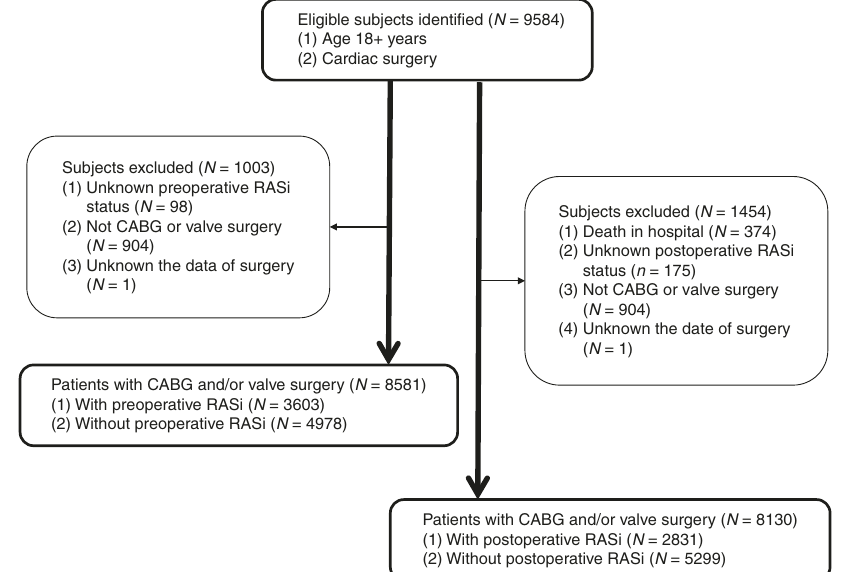
Fig. 1 Study population recruitment summary. RASi renin-angiotensin system inhibitors, CABG coronary artery bypass graft Table 1 Demographic and clinical characteristics: preoperative RAS inhibitors Unadjusted Inverse probability weighted adjusted Matched data